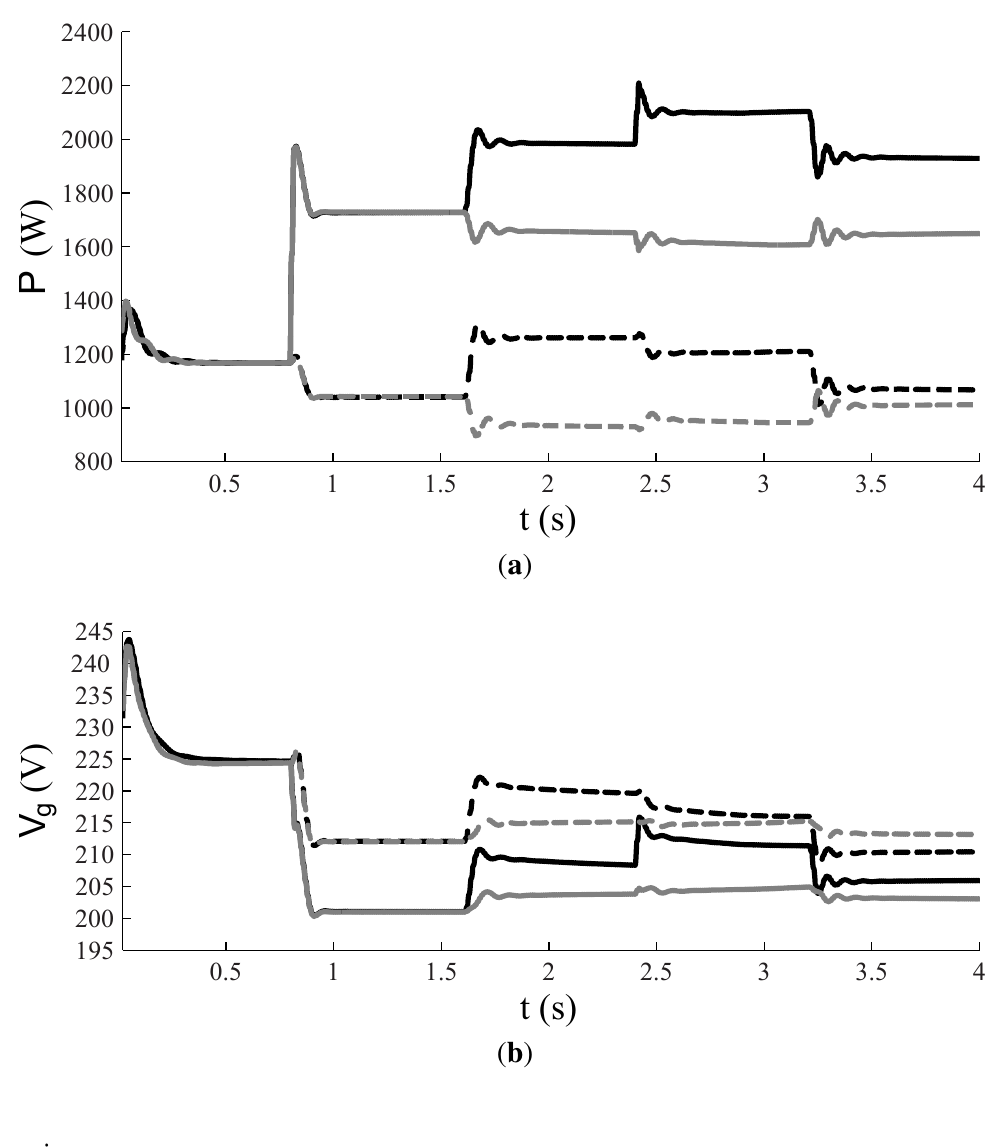
Figure 6. Dynamic simulation with inductance in the lines: ( a ) Output power P ; ( b ) Terminal voltage V . ( — = DG 1/ phase a; - - - = DG 1/phases b and c; — (gray)= DG 2/phase a; g - - - (gray)= DG 2 /phases b and